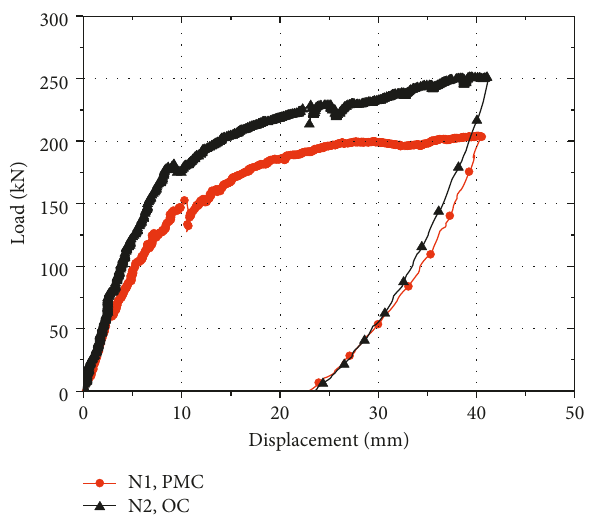
Figure 23: Load-displacement curves of N1 and N2 specimens.